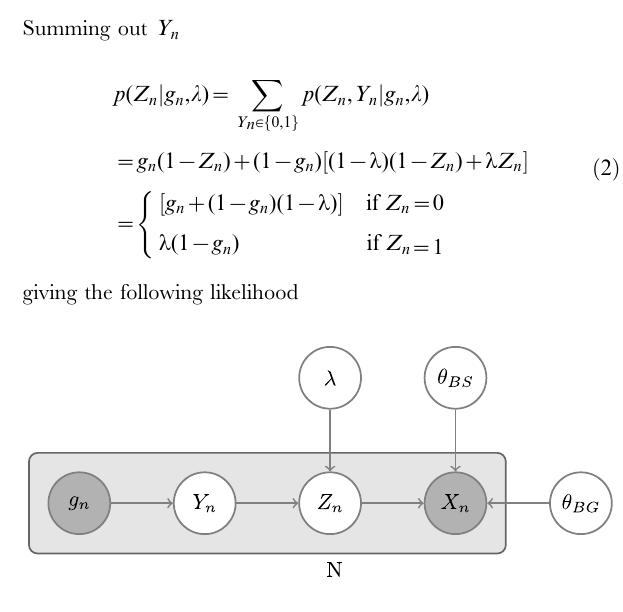
Figure 4. Our model in plate notation.